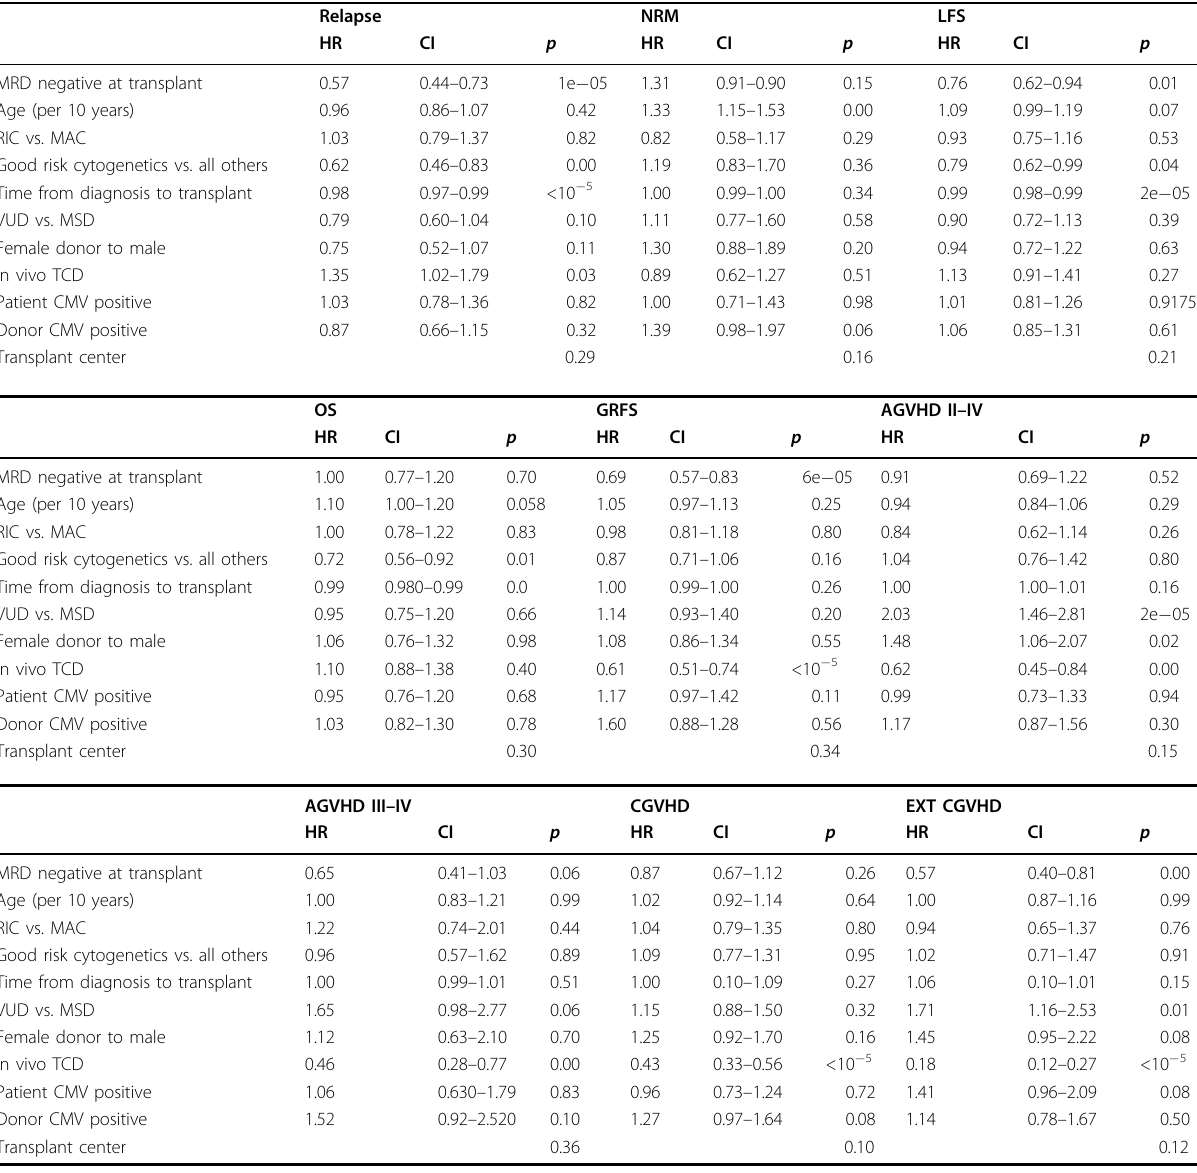
Table 3 Cox regression analysis of transplant outcomes using variables derived from the outcome of univariate analysis or established risk